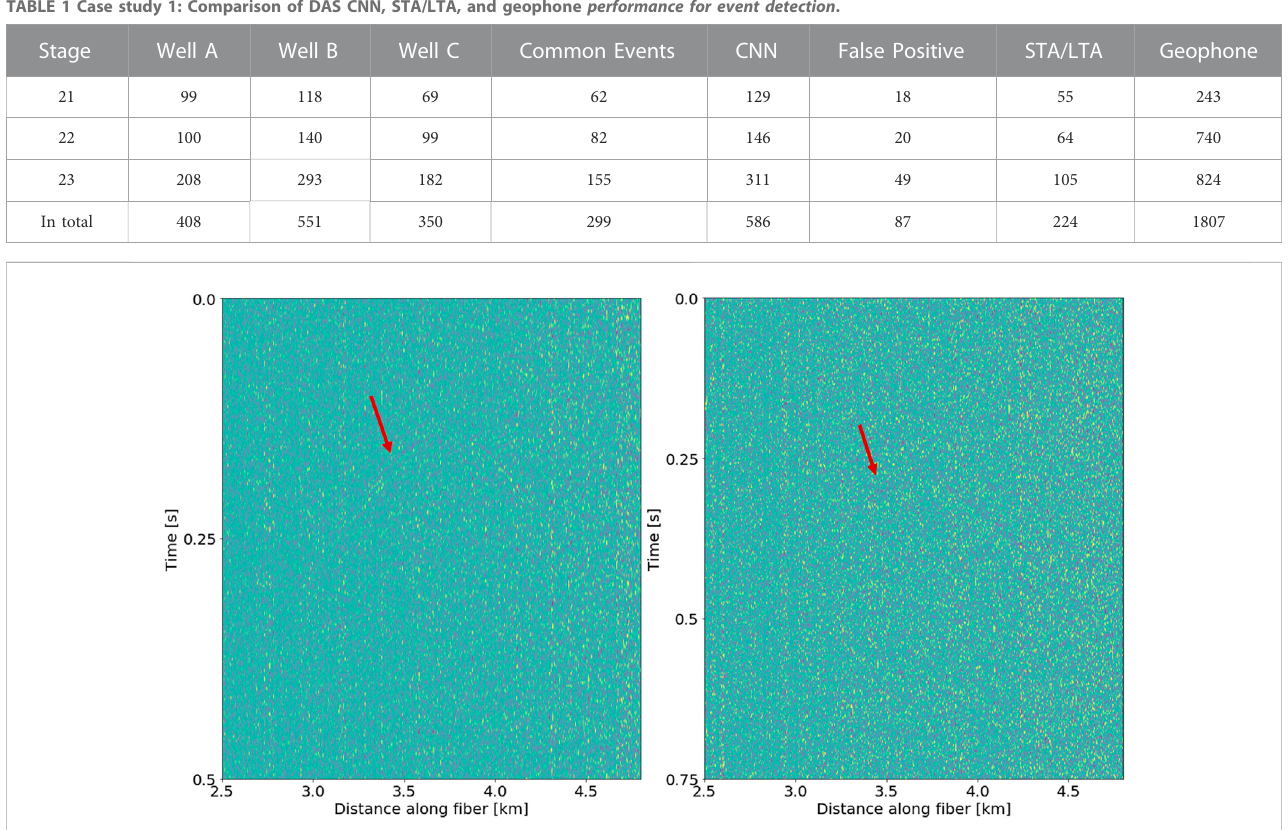
FIGURE 7 Case study 1: Examples of extremely weak events detected by CNN but missed by both STA/LTA and manual labels.